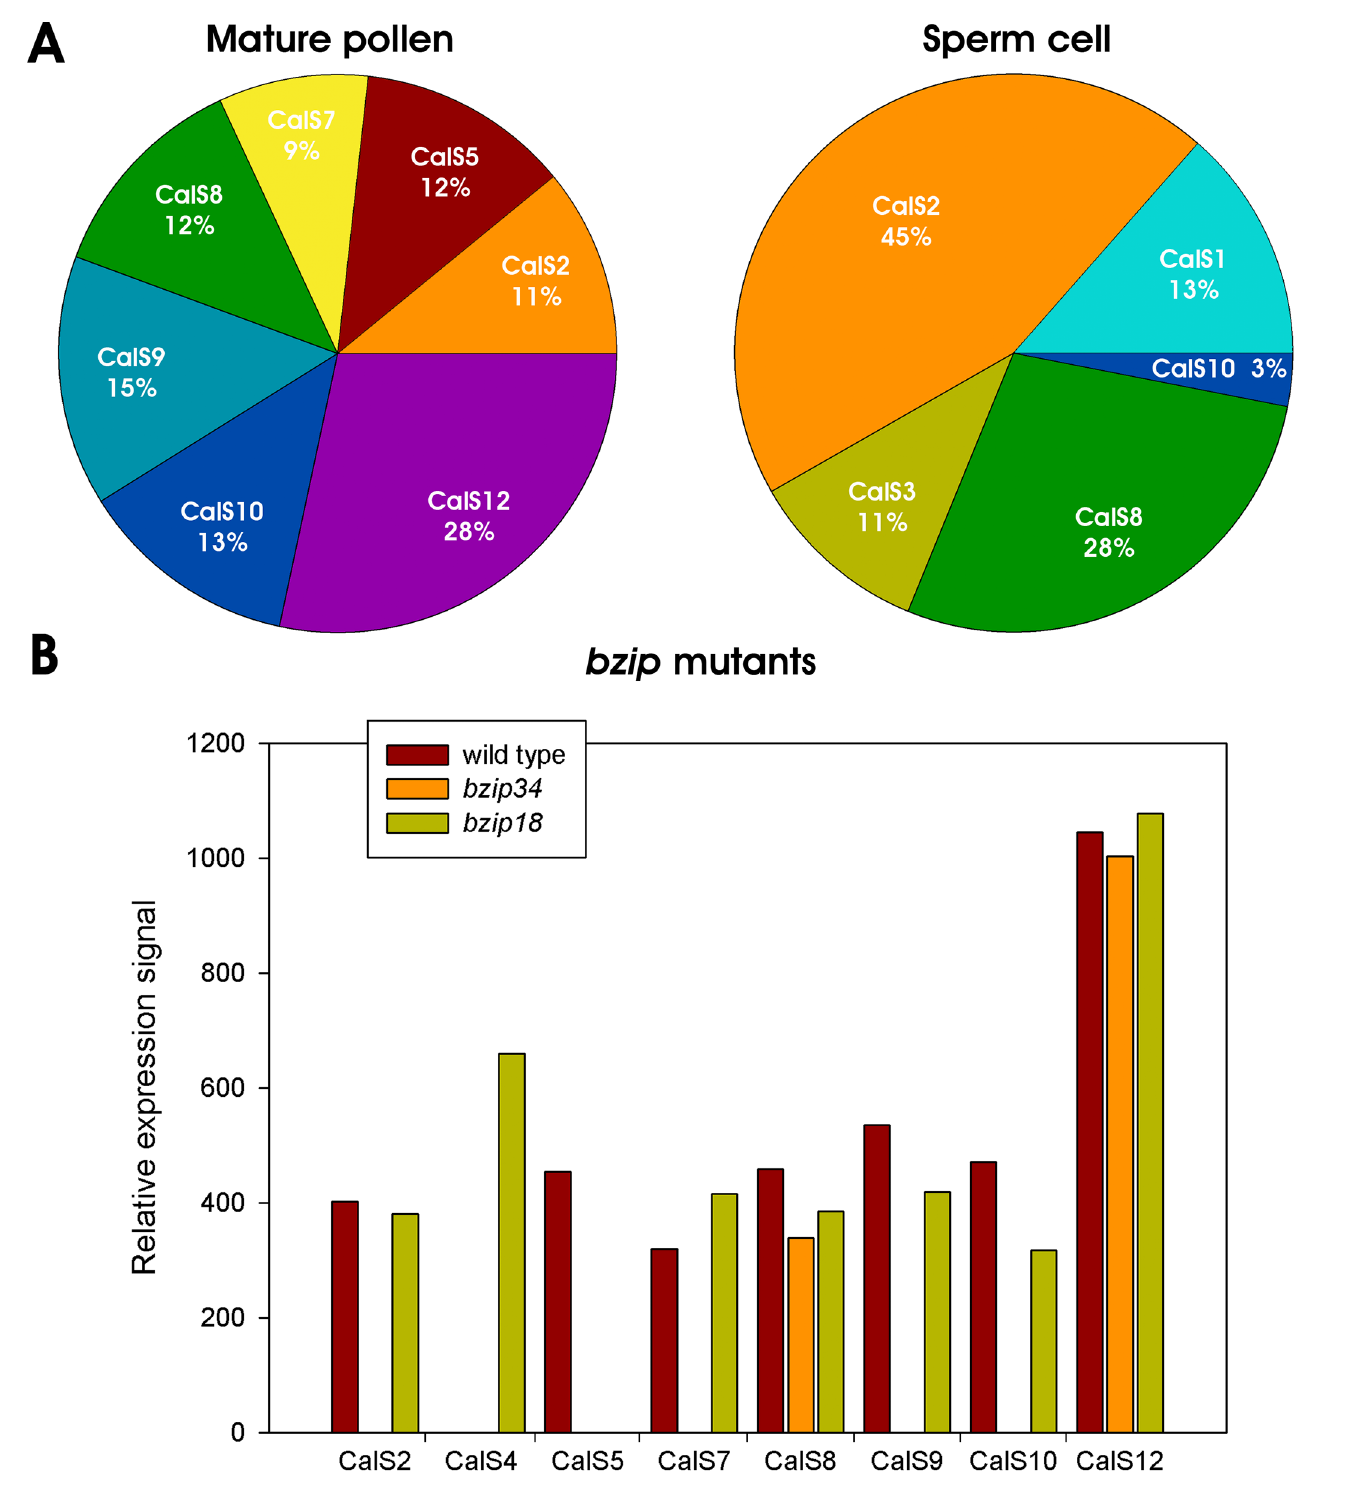
Fig 3. Callose synthase expression in Arabidopsis thaliana pollen. A) Abundanceof expressed CalS transcripts in mature pollenand sperm cells. B) Expression profiles of pollen-expressed CalS transcripts in wild type Col-0 and bzip18/- and bzip34/- mutant A . thaliana mature pollen.